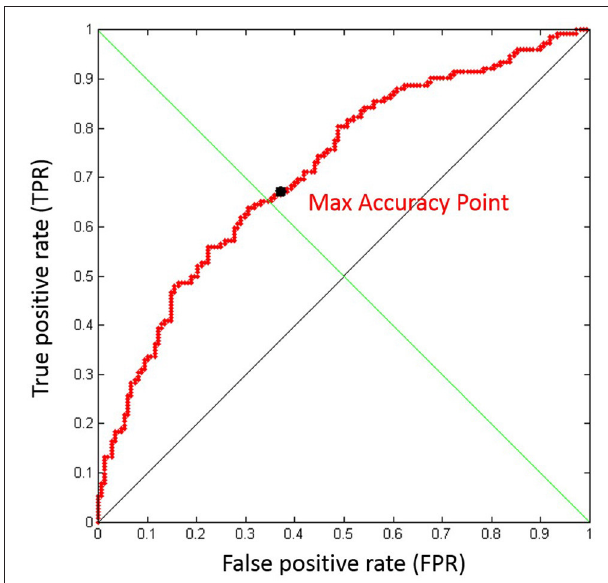
FIGURE 3 | Graphical representation of the averaged Receiver Operating Characteristic (ROC) over all the subjects related to the offline k-fold cross-validations performed to find the best threshold. The achieved offline classification performance was of 75 ± 10%. The mean threshold value was 0.48 ±